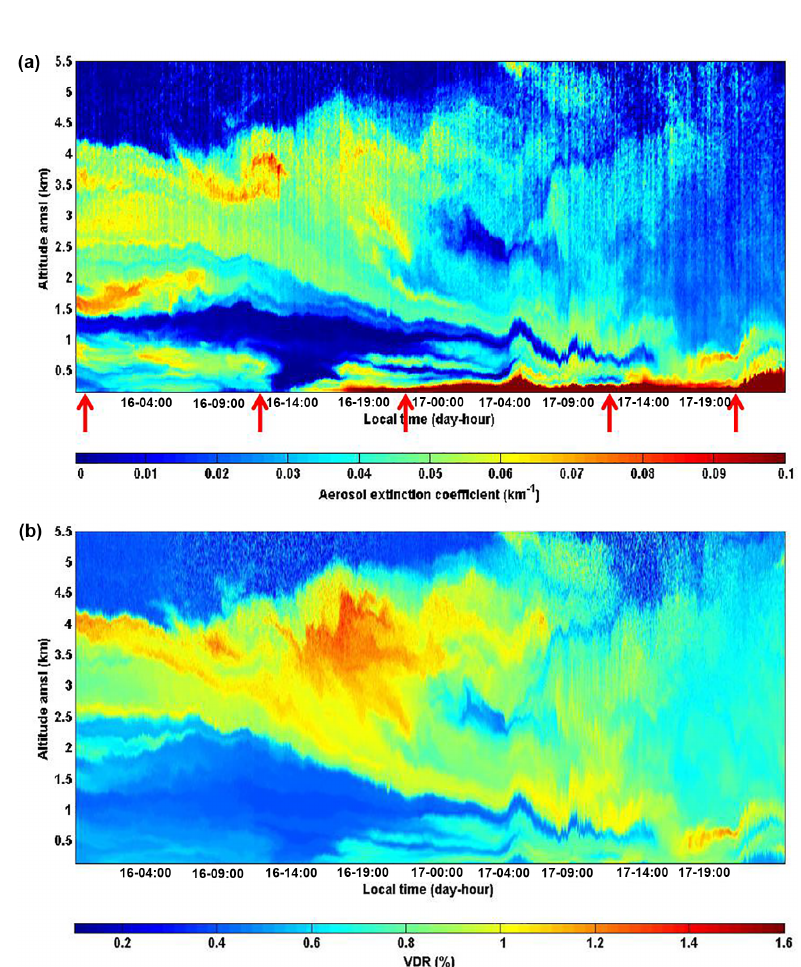
Figure 5. Lidar-derived time-height cross sections of the aerosol extinction (a) and volume depolarisation ratio (VDR) (b) at Minorca from 15 June, 22:00 to 17 June, 24:00UT. The red arrows indicate the time of the 5LDB launches. A high depolarisation ratio indicates desert dust. Courtesy of Patrick Chazette and Julien Totems, after Chazette et al.